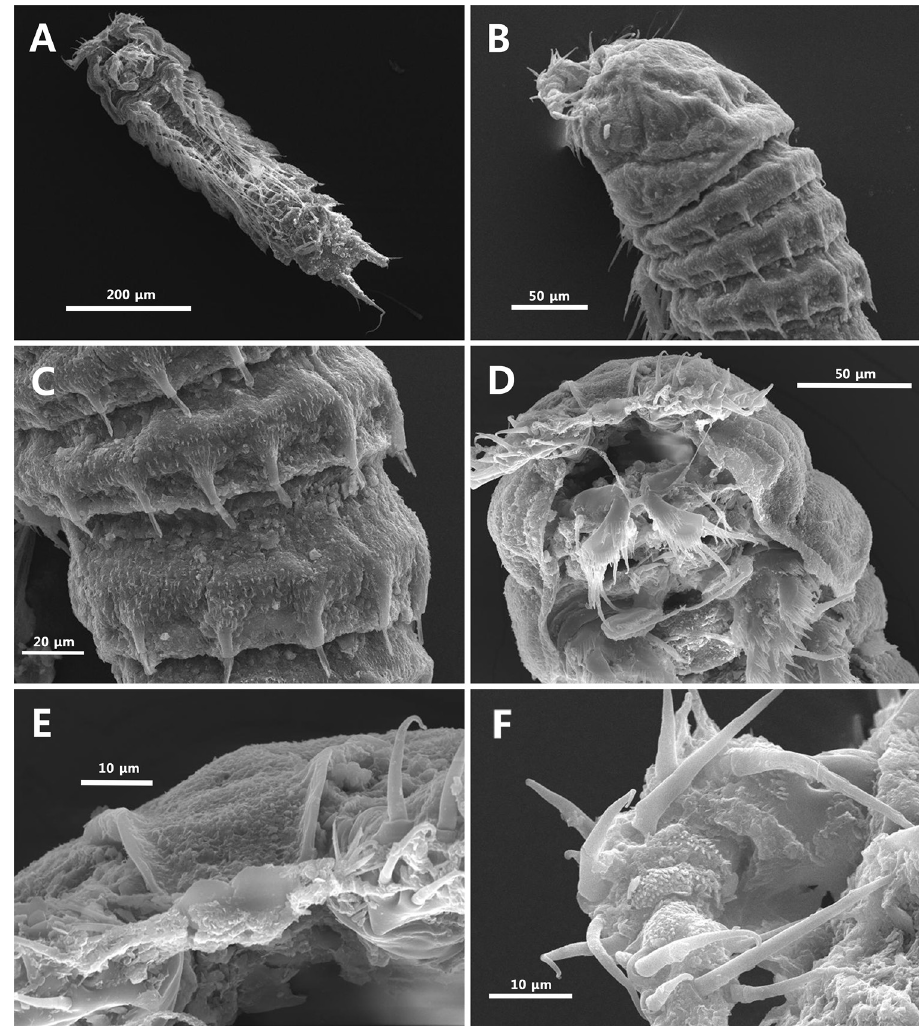
Figure 8. Scanning electron microscope photographs. Strongylacron glabrum sp. n. female: A habitus, ventral B prosome, dorsolateral C thoracic somites 2–4, dorsolateral D cephalothorax, ventral E rostrum, anterior F antennules,